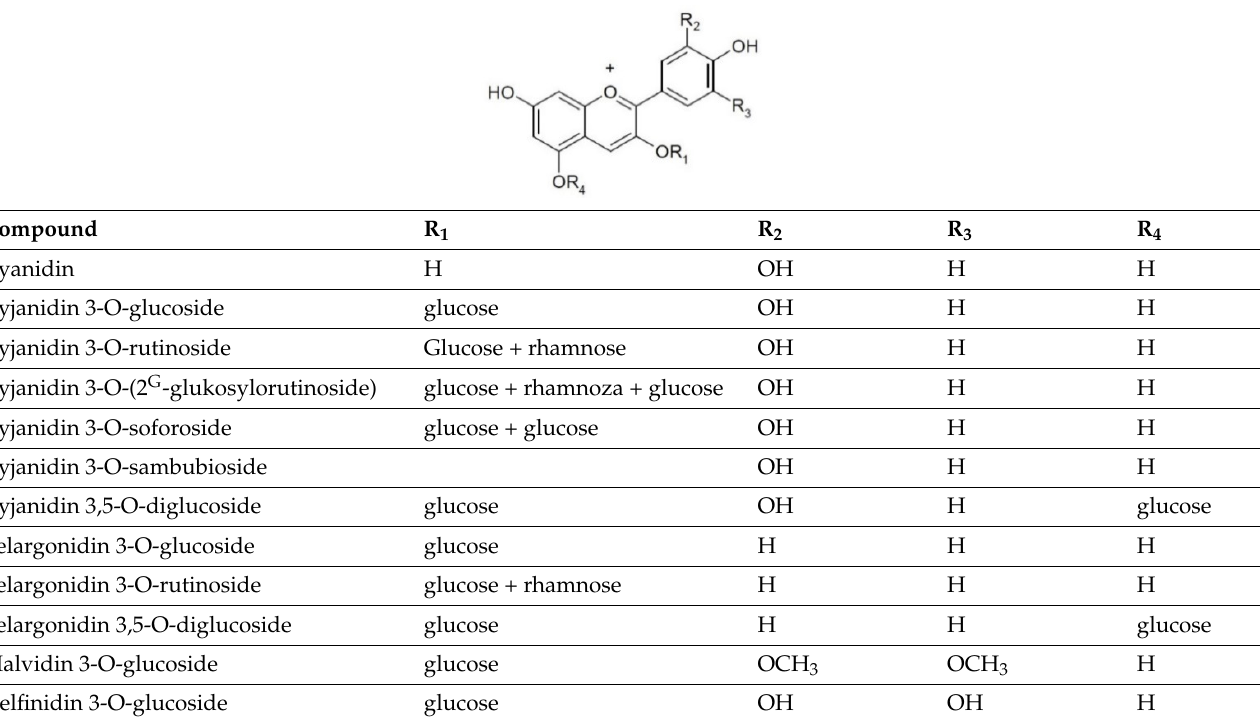
Table 2. Structural formulas of selected anthocyanins.